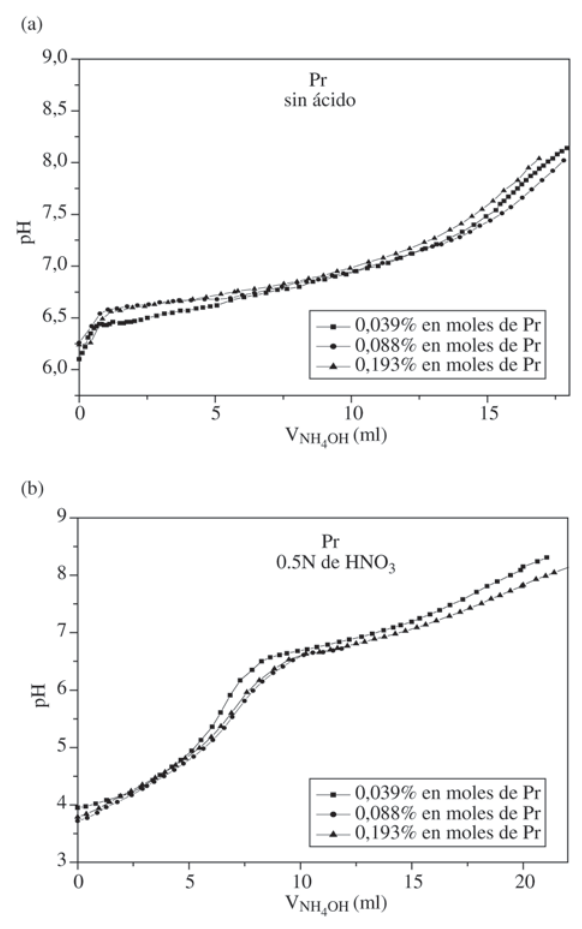
Figura 1. Curvas de valoración potenciométrica obtenidas para el sistema acuoso de cinc - praseodimio sin ácido (a) y con ácido